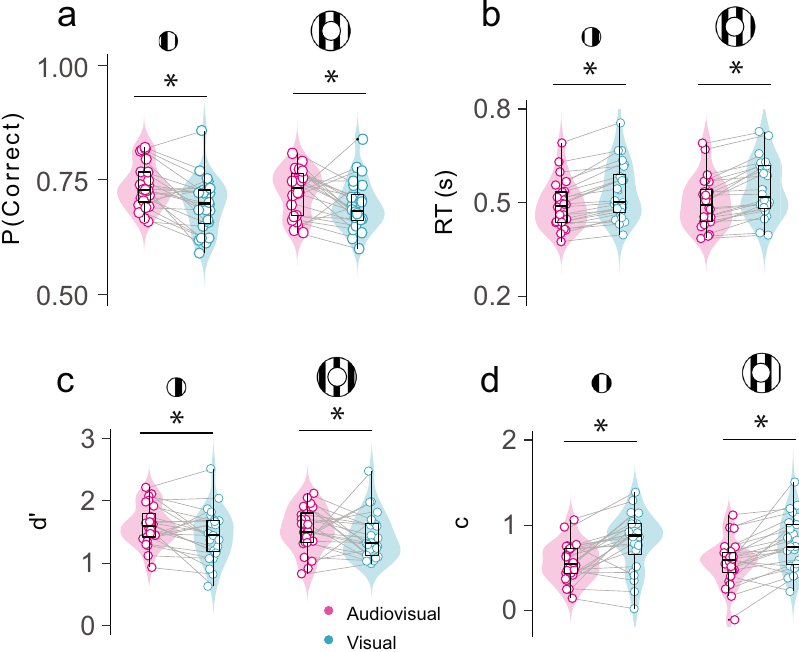
Fig. 2 Sounds modulate participants visual detection performance. Accuracy ( a ), reaction times ( b ), sensitivity ( c ) and criterion ( d ) are depicted for each modality (audiovisual/visual), visual eccentricity condition (center/periphery) and participant. Inside the violin plot, the horizontal black line re fl ects the median, the thick box indicates quartiles, and whiskers 2 times the interquartile range. Gray horizontal lines connect participants scores across conditions. Asterisks indicate signi fi cant differences between the visual and audiovisual conditions ( P <